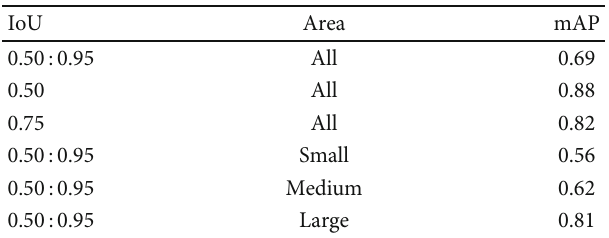
Table 5: The veri fi cation results of the SCA-SSD hand detector